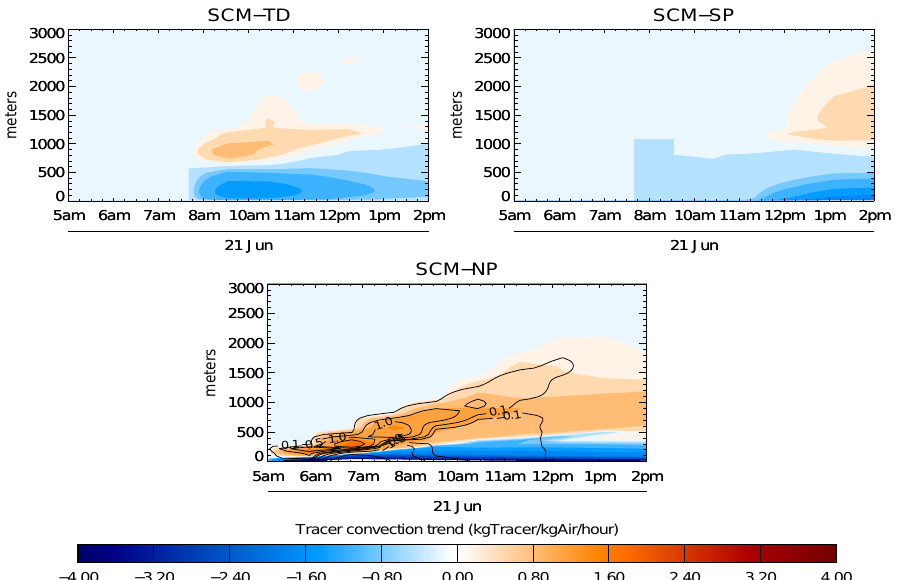
Figure 2. Deep convection trends (in kgTracer/kgAir/hour) simulated in SCM-TD (top left) and SCM-SP (top right) configurations are compared with thermal trends simulated by SCM-NP in an ideal shallow convection over land case. Positive (Negative) trends are represented in shades of red (blue, respectively). Black contours represent tracer trends in the LES. Contour values are 2.0, 1.0, 0.5 and 0.1kgkg − 1 h − 1 (and for negative trends, same values with a negative